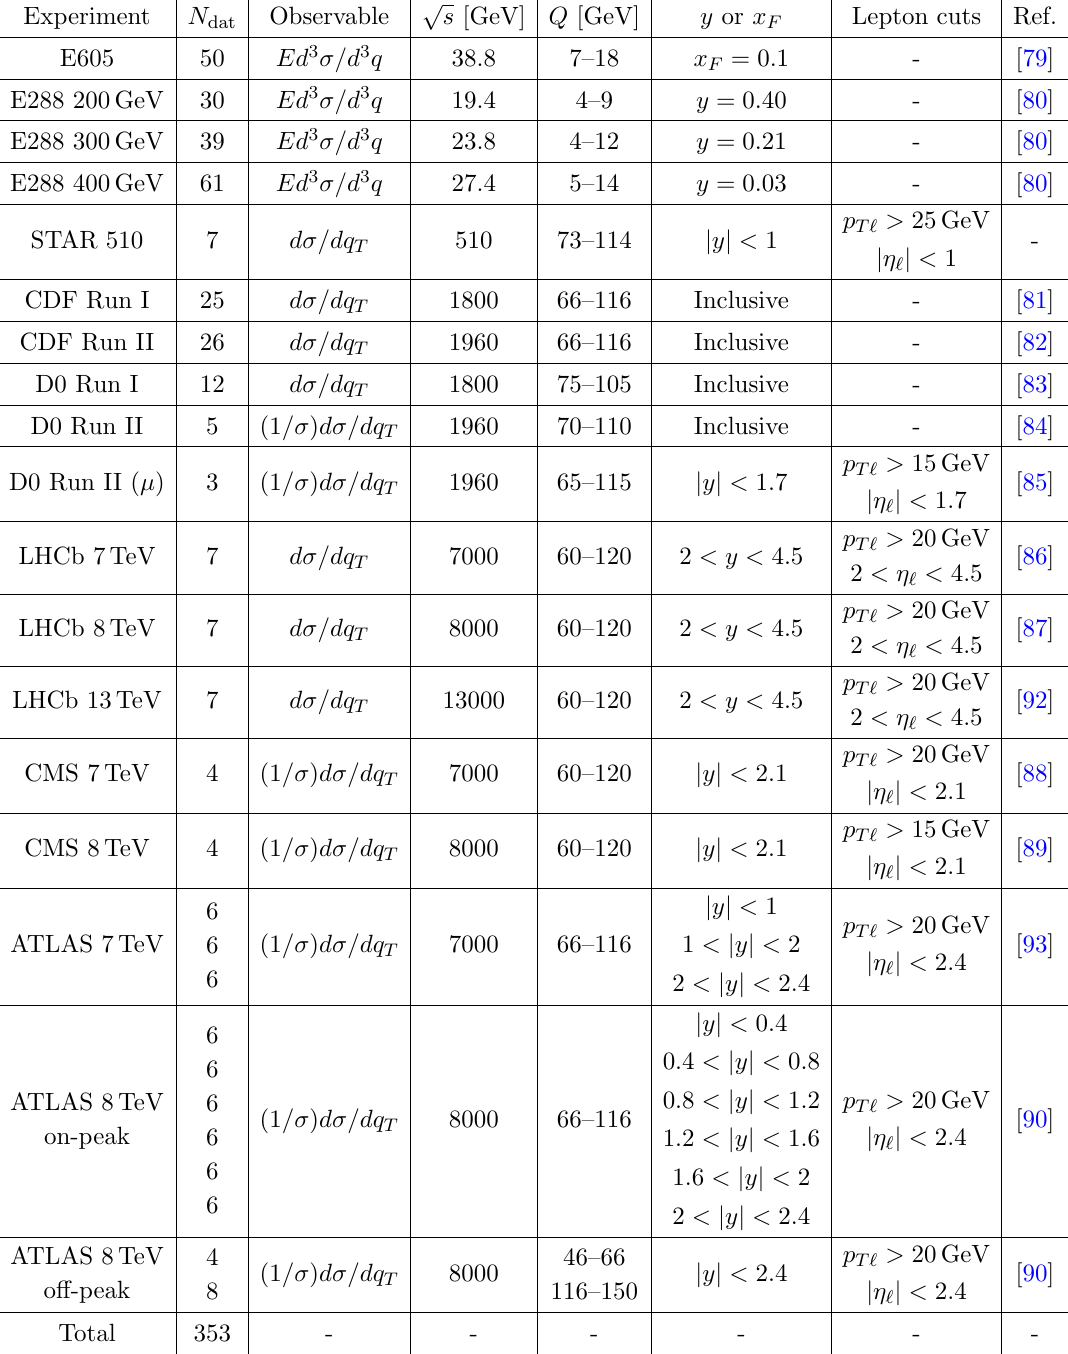
Table 2 . Breakdown of the datasets included in this analysis. For each dataset, the table includes information on: the number of data points ( N dat ) passing the nominal cut on q T =Q , the observable p delivered, the center of mass energy s , the range(s) in invariant mass Q , the angular variable (either y or x F ), possible cuts on the single (cid:12)nal-state leptons, and the public reference (when available). The total number of data points amounts to 353. Note that for E605 and E288 400 GeV we have excluded the bin in Q containing the (cid:7) resonance ( Q ’ 9 : 5